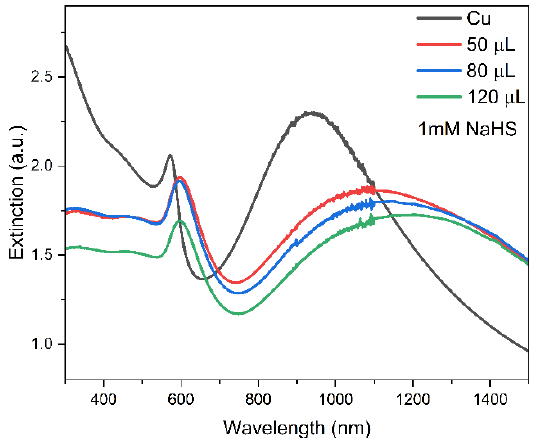
Figure 3. Extinction spectra of Cu NRs when adding different amounts of sulfur source (1 mM NaHS).